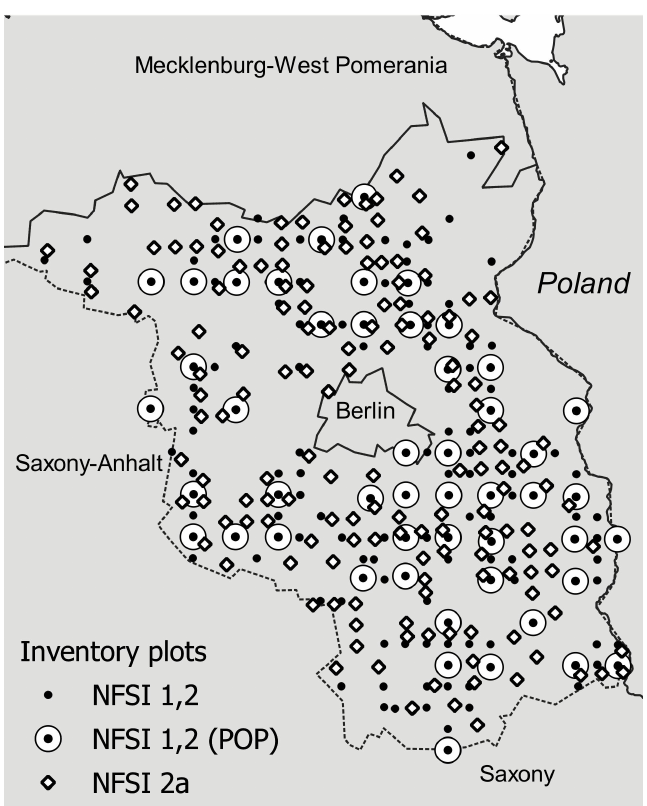
Figure 1. Map of the plots for investigation in the state of Brandenburg; NFSI 1,2 (POP) = sub-sample of the NFSI with analysis data on persistent organic